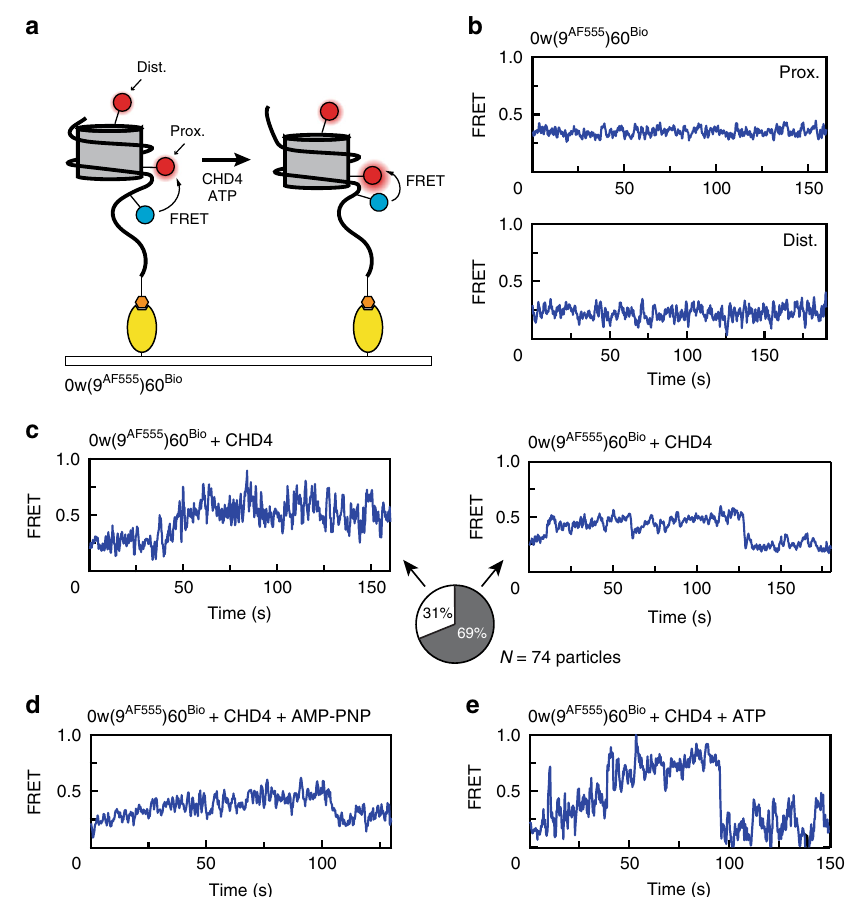
Fig. 5 CHD4 binding induces changes in extra-nucleosomal DNA at the TA-poor side. a Schematic showing the labelling scheme for 0w(9 AF555 )60 Bio and nucleosomal conformations before and after CHD4 remodelling. b FRET vs time traces of 0w(9 AF555 )60 Bio alone with a proximal (top) and distal (bottom) AF647-labelled H2A. c FRET vs time trace of 0w(9 AF555 )60 Bio bearing a distal AF647 label, showing a gradual increase upon the addition of 2 nM CHD4. This newly established structure can be relatively stable (left) or can be transient, dropping back to the initial state (right). The proportions of each scenario (from 74 molecules) are illustrated as a pie chart. d FRET vs time trace of 0w(9 AF555 )60 Bio bearing a distal AF647 label, showing an increase upon the addition of 2 nM CHD4 and 1 mM AMP-PNP. e FRET vs time traces of 0w(9 AF555 )60 Bio bearing a distal AF647 label showed a greater increase during CHD4 remodelling in presence of ATP, comparing to the changes induced by CHD4